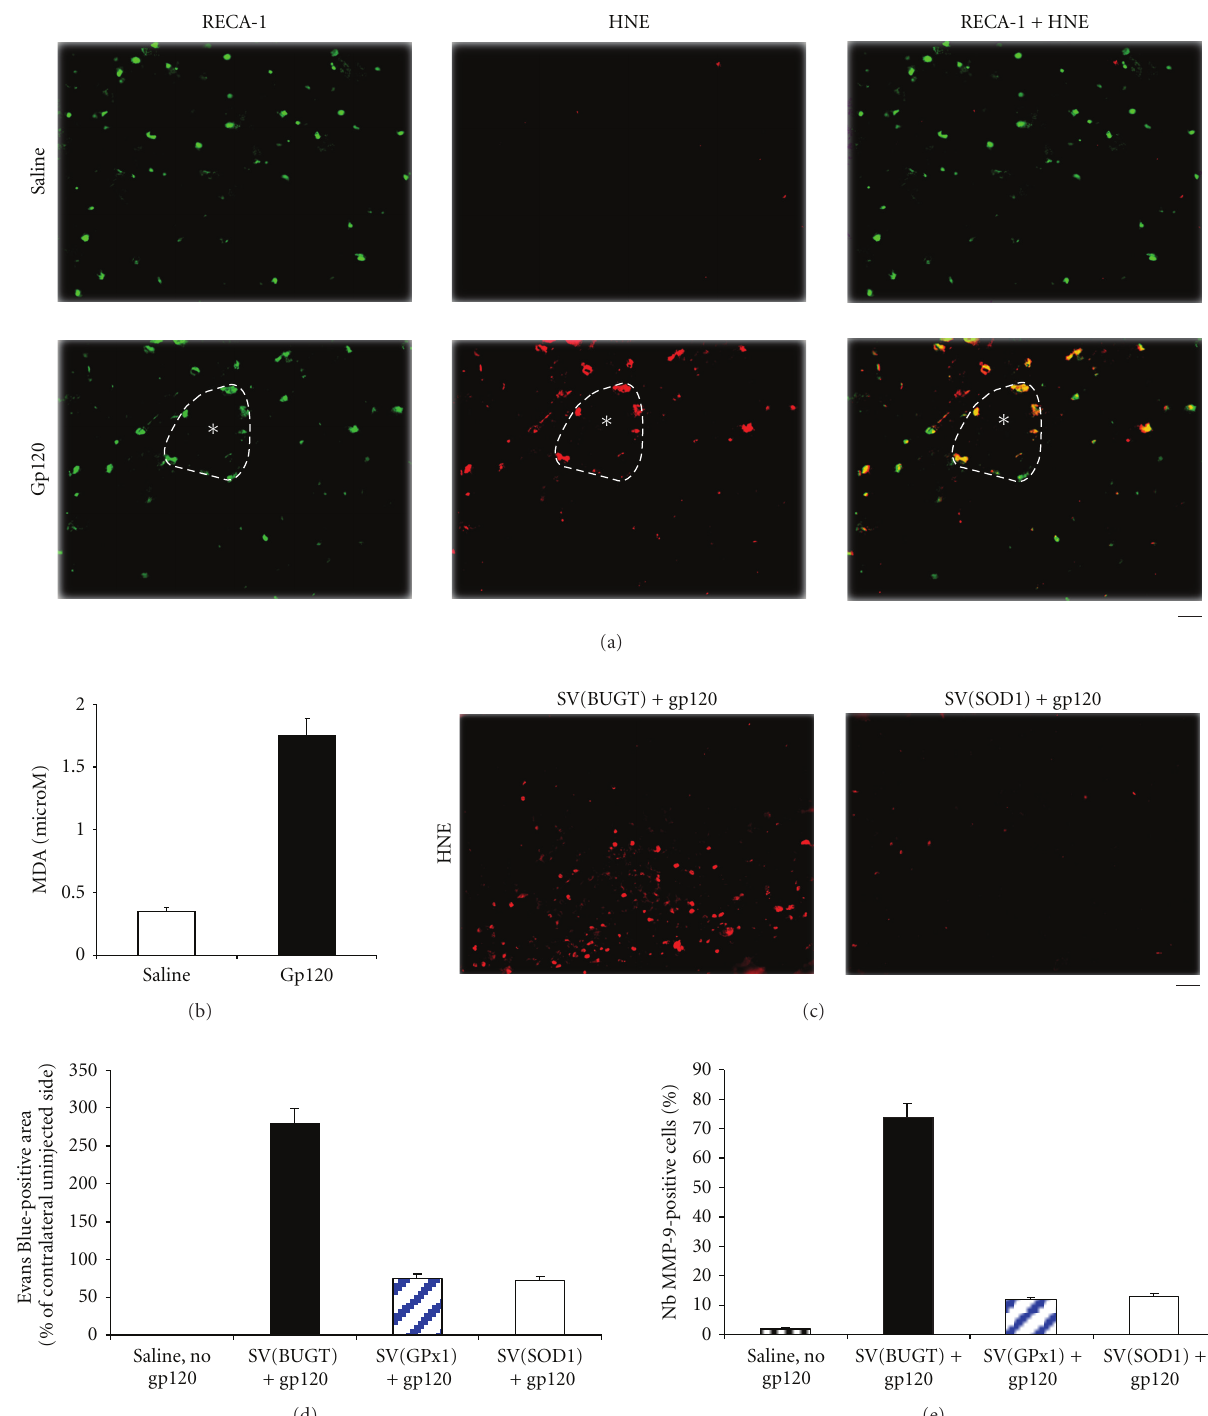
Figure 7: Role of oxidative stress in gp120-induced BBB disruption. (a) Cryostat sections of rat CP injected 1 hour earlier with saline or 500 ng gp120 were immunostained for HNE, a marker of lipid peroxidation, and RECA-1, a marker of endothelial cells. HNE immunoreactivity was seen in the CPs injected with gp120 and colocalized with RECA-1 while no HNE immunostaining was detected in CPs injected with saline. (b) Malondialdehyde (MDA) levels were increased in the CPs injected with 500 ng gp120. (c) Prior gene delivery of antioxidant enzymes into the CP before injection of gp120 decreased the number of HNE-positive cells when compared with injection of the vector control SV(BUGT). (d) Gene delivery of antioxidant enzymes by SV40-derived vectors in the CP 1 month before the injection of gp120 into the same structure mitigated the extent of BBB breakdown after intra-CP injection of gp120, as demonstrated by spectrophotometry measurements of EB. (e) Fewer MMP-9-positive cells were observed with prior gene delivery of antioxidant enzymes into the CP before injection of gp120. SV(BUGT) was used as a control vector. Bar: (a) 80 μ m; (c) 80 μ